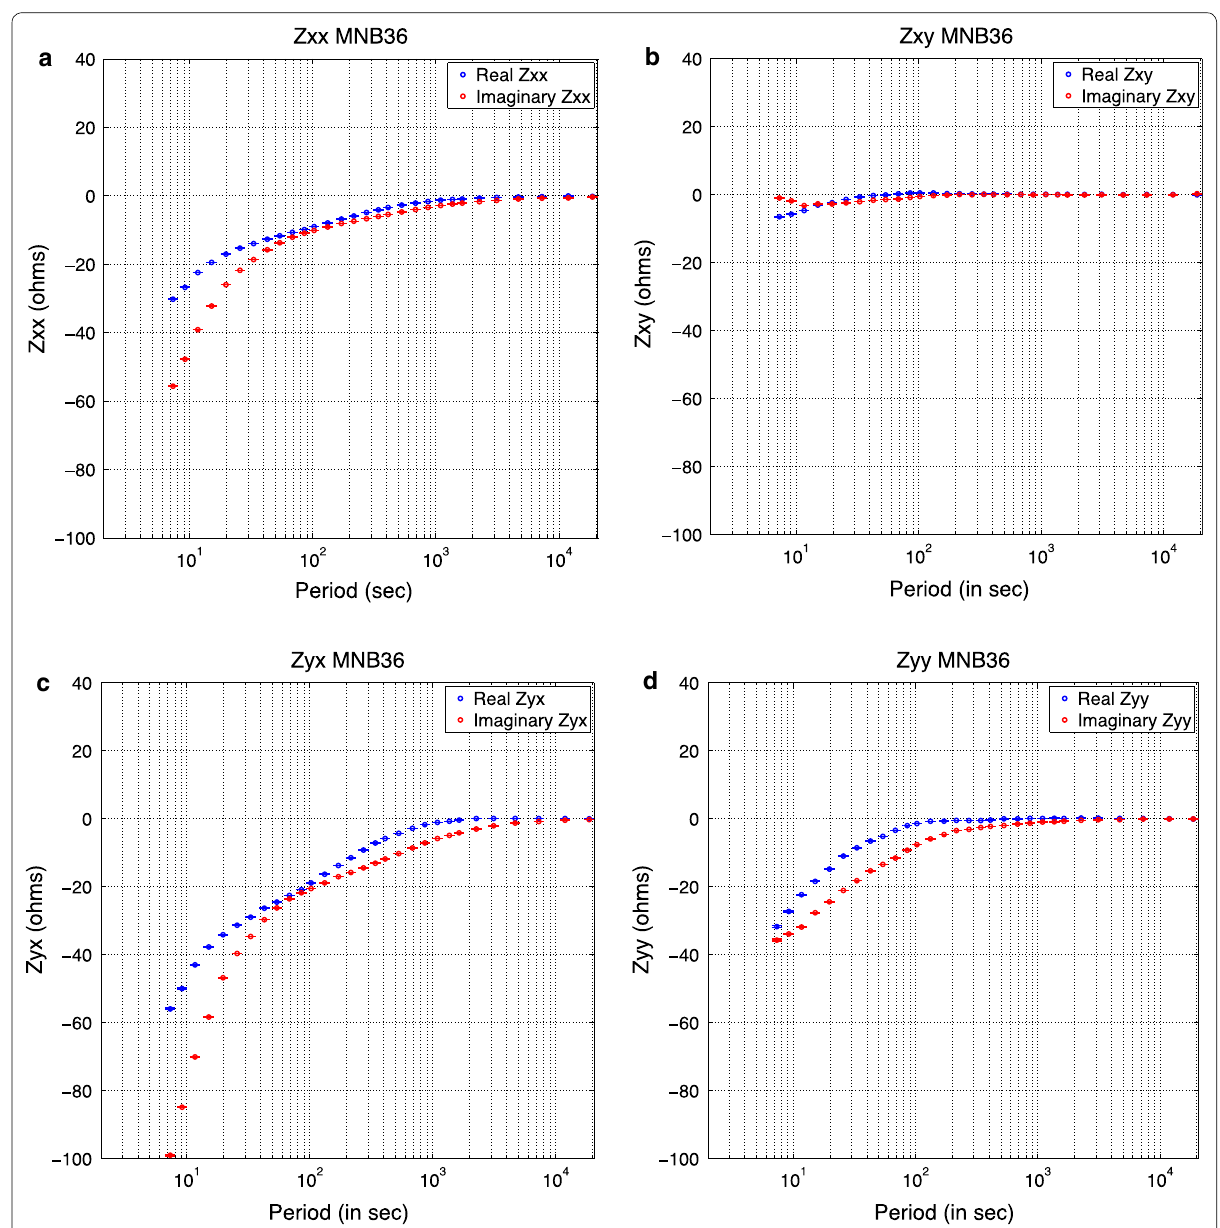
Fig. 3 Real (blue) and imaginary (red) impedance plots from the EarthScope survey site MNB36, which were used to produce estimations of the geoelectric field with the Brandon (BRD) observatory geomagnetic time